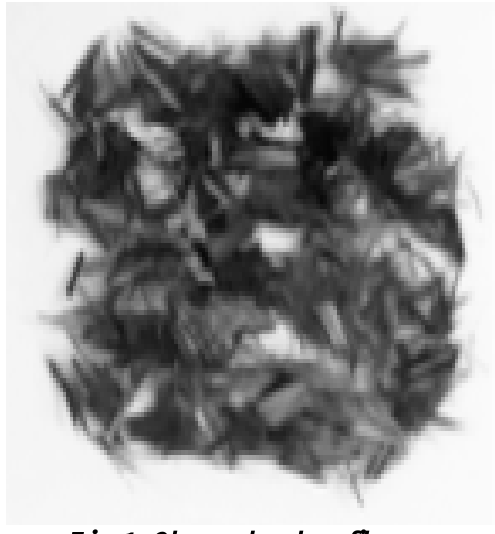
Fig. 1: Chopped carbon